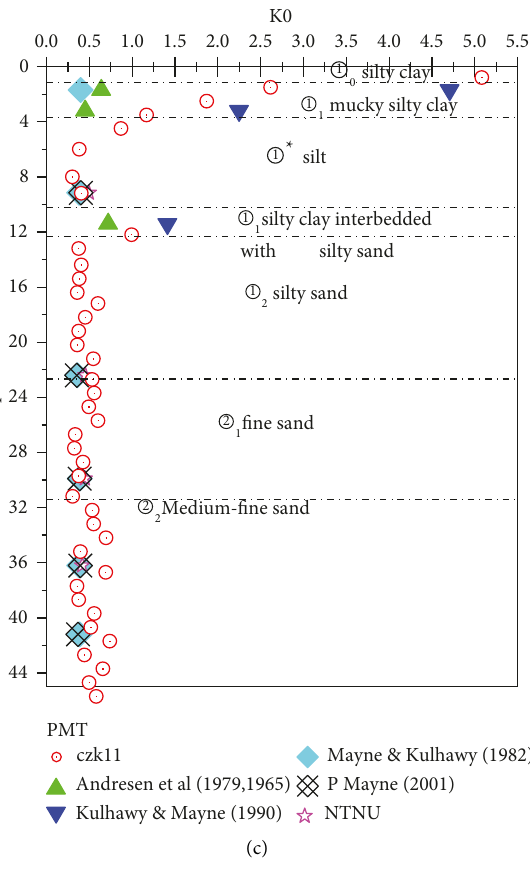
0 using different